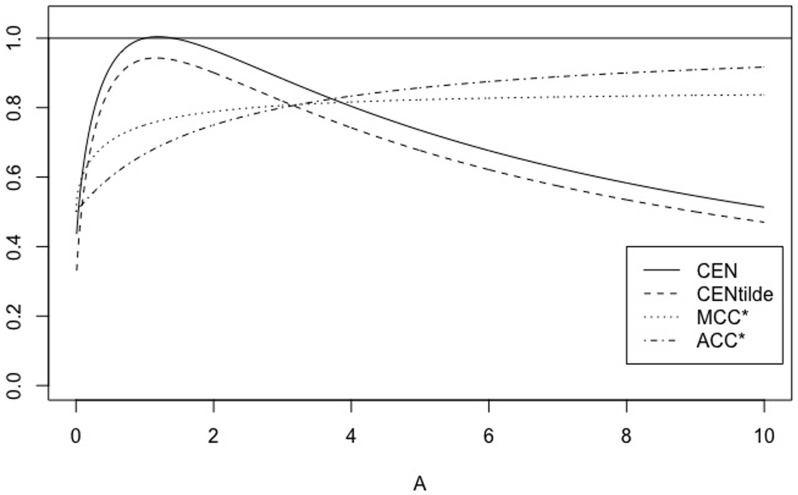
Family VA.CEN, MCEN, ACC* and MCC* for A ∈ (0, 10].